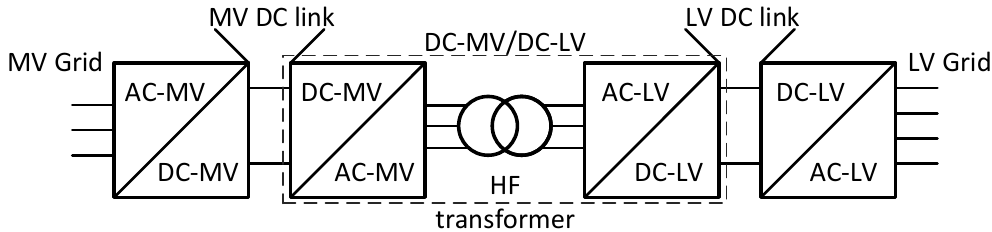
Figure 1. The block scheme of the Solid-State Transformer consisting of di ff erent power conversion stages.